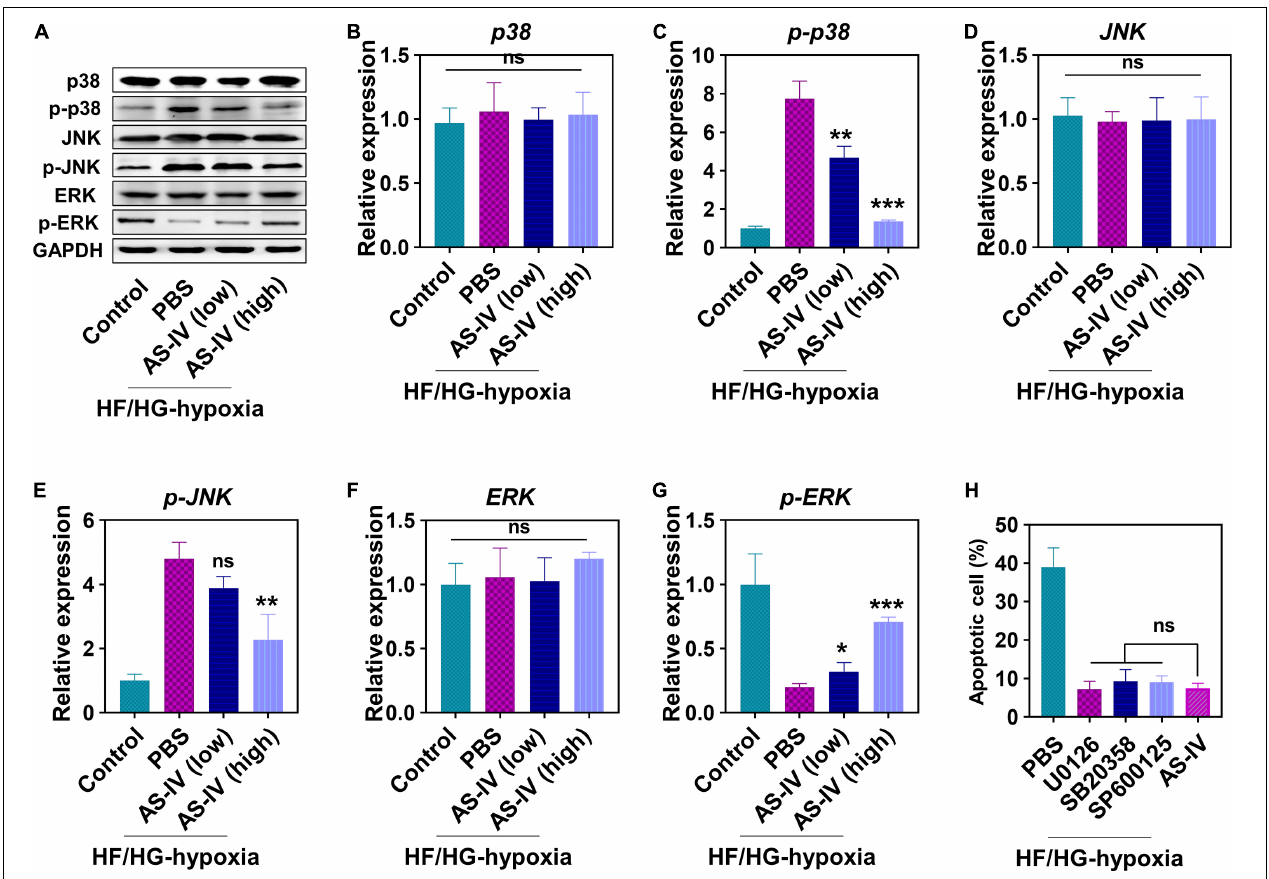
FIGURE 2 | Effect of AS-IV on the protein expression in mitogen-activated protein kinase (MAPK) signaling pathway post HG/HF and hypoxia treatment. (A) Representative images of Western blot of MAPKs-p38 enzymes (p38), p-p38, c-Jun NH2-terminal kinases (JNK), p-JNK, extracellular signals-regulated kinases (ERK), and p-ERK. The protein expressions of p38 (B) , p-p38 (C) , JNK (D) , p-JNK (E) , ERK (F) , and p-ERK (G) were quantified by Image J software. H9c2 myocytes were cultured in HG/HF medium for 12 h followed by hypoxia for 2 h. Then H9c2 myocytes were treated with PBS, MAPK inhibitors (U0126, 25 nM; SB20358, 25 nM; SP600125, 25 nM), AS-IV (50 ng/ml), and the cell apoptosis was examined 48 h later. (H) Cell viability of H9c2 myocytes. Data represent means ± SD. * p < 0.05; ** p < 0.01; *** p < 0.001, versus the PBS group, normalized to GAPDH level, n = 3 biologically independent